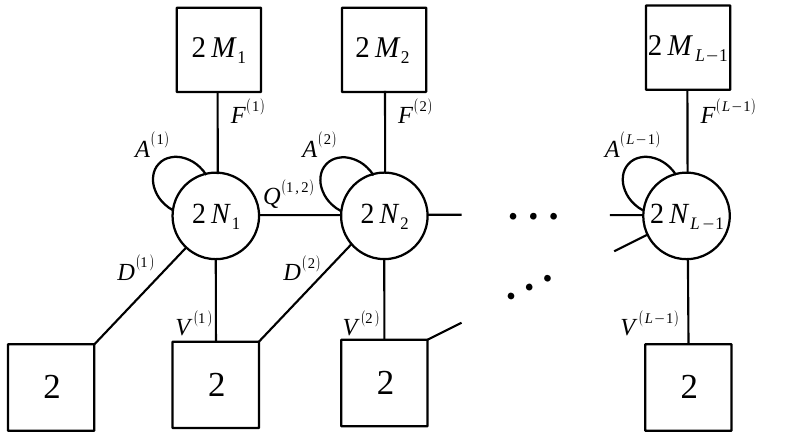
(cid:26) i . The mirror-like dual i =1